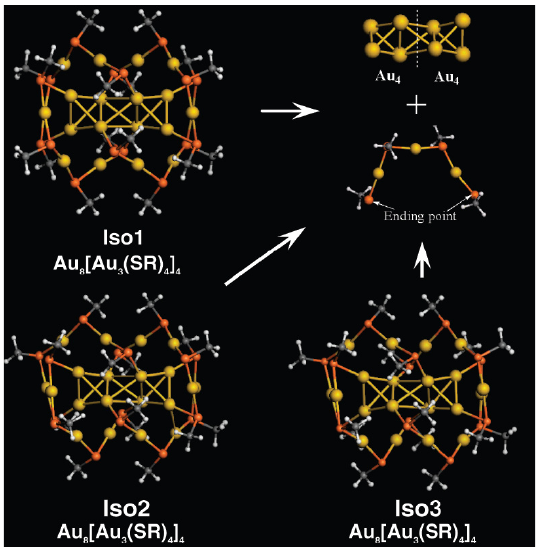
Figure 2. Two views of Au